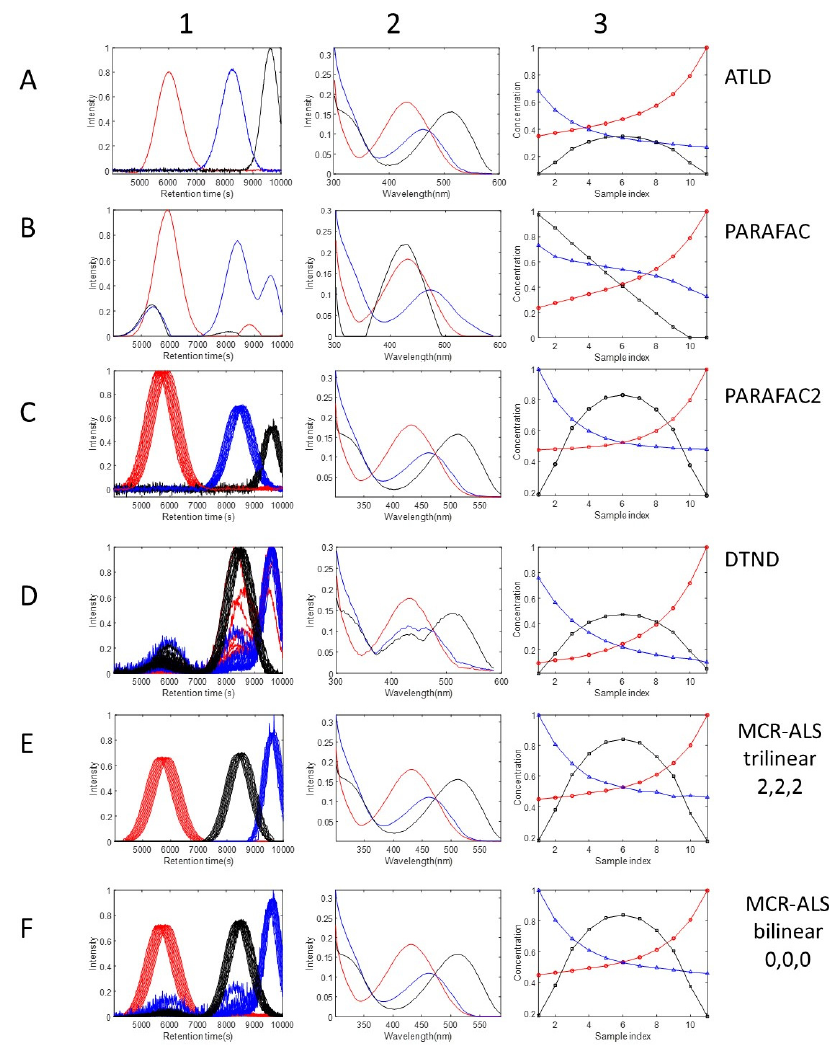
Figure 4. Elution, spectra, and sample profiles resolved by ATLD ( A1 , A2 and A3 ), PARAFAC ( B1 , B2 and B3 ), PARAFAC2 ( C1 , C2 and C3 ), DNTD ( D1 , D2 and D3 ), MCR-ALS mixed trilinear (2,2,2) ( E1 , E2 and E3 ), and MCR-ALS bilinear (0,0,0) ( F1 , F2 , F3 ) in the analysis of the synthetic LC-DAD dataset. See Section 4.1 and Table 1.